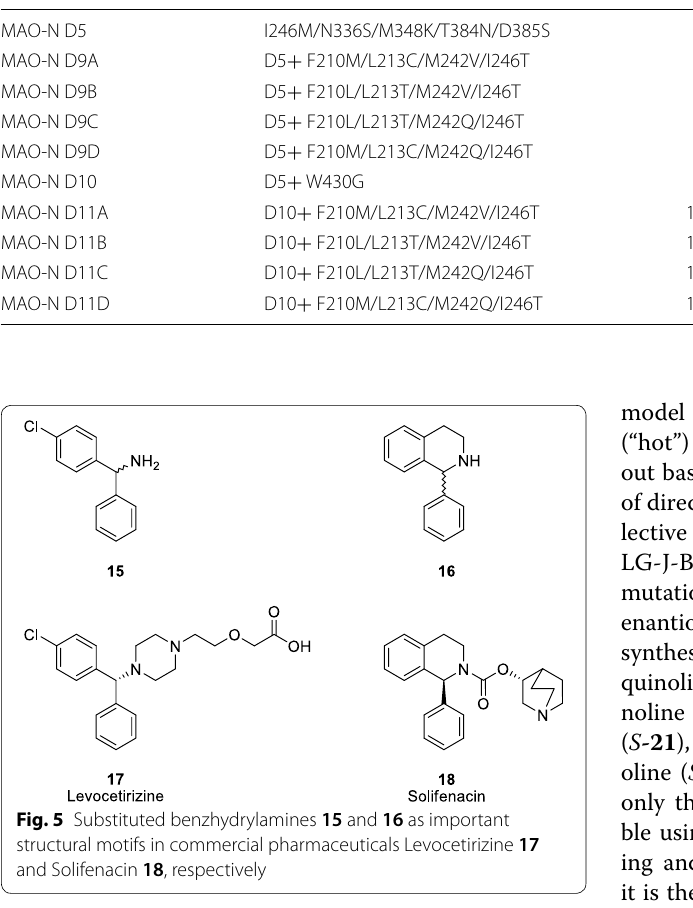
Table 1 MAO-N variants obtained by directed evolution and respective oxidation rate towards ( S )-15 and ( R )-15 MAO‑N variant